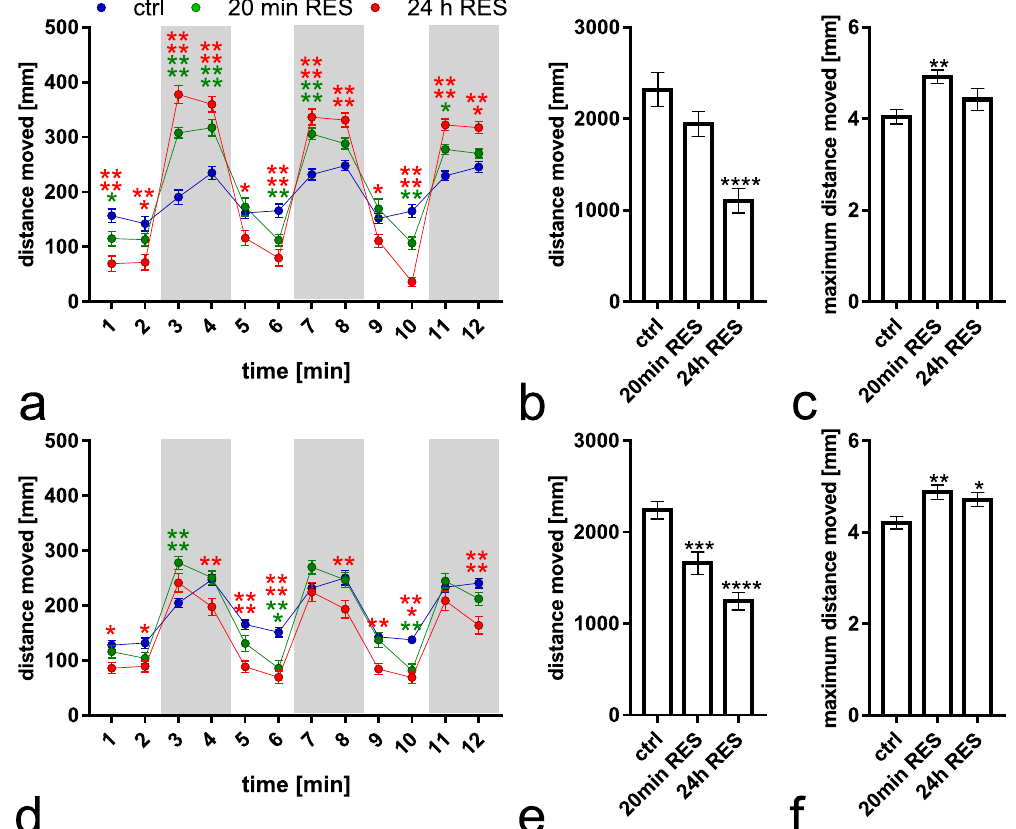
was significantly decreased in reserpine treated larvae with both treatment durations manner during a 15 min trial ( b , e ). The maximum distance moved per bout during the same trial was increased in the 20 min treated group and mainly unaltered in the 24 h treated group ( c , f ). When altering between light and dark conditions ( a , d , dark phase indicated with grey background), the reserpine treated larvae showed increased locomotion in the 2 min dark phase compared with controls at 24 h after administration of reserpine ( a ). When returning to the light phase, the locomotion activity decreased to the level preceding the dark phase. At 72 h after administration of reserpine ( d ), the difference between reserpine treated larvae and controls during the dark phase was less apparent, and the 24 h treated larvae actually move significantly less than controls at some time points. N = 48 in each group. Data presented as mean ± SEM. Statistical analyses were done using Kruskal- Wallis test followed by Dunn’s post hoc test ( b , c ) 1-way ANOVA ( e , f ) or 2-way ANOVA ( a , d ) followed by Tukey’s post hoc test. * p < 0.05, ** p < 0.01, *** p < 0.001, **** p < 0.0001 according to the multiple comparison